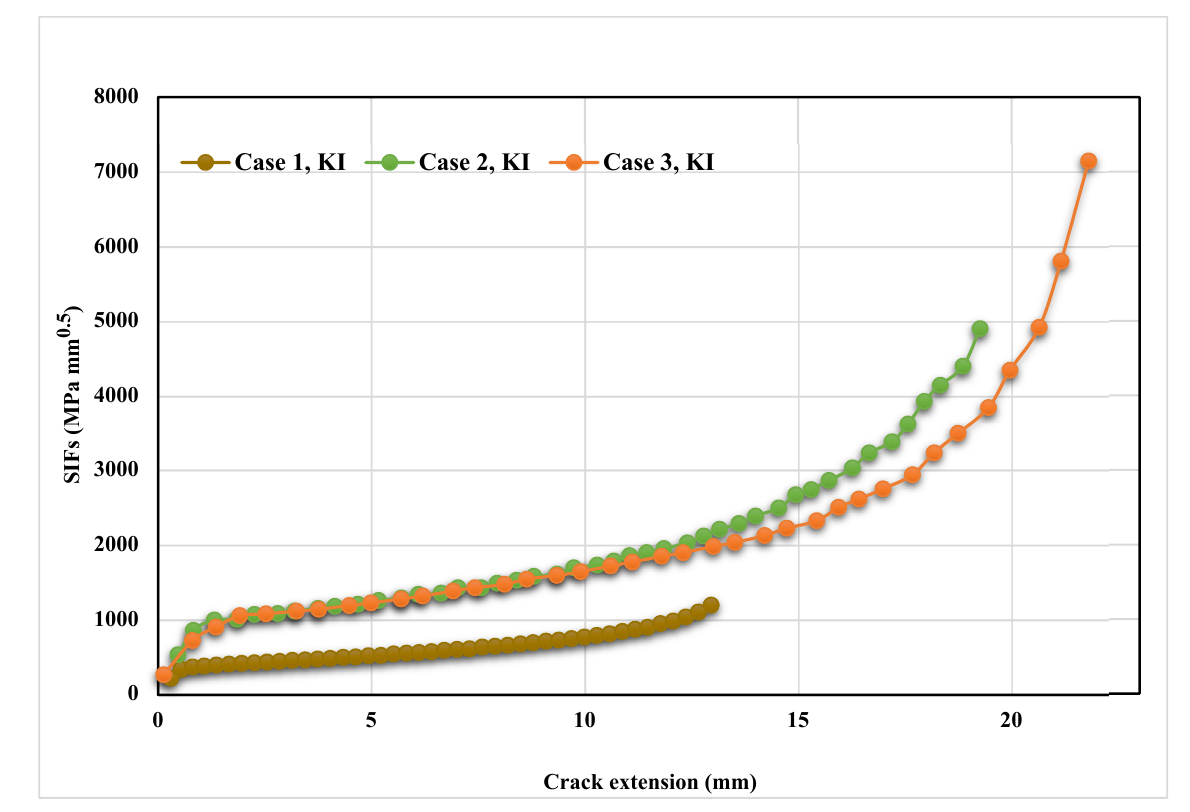
Figure 14. Predicted values of K I for the three different cases.